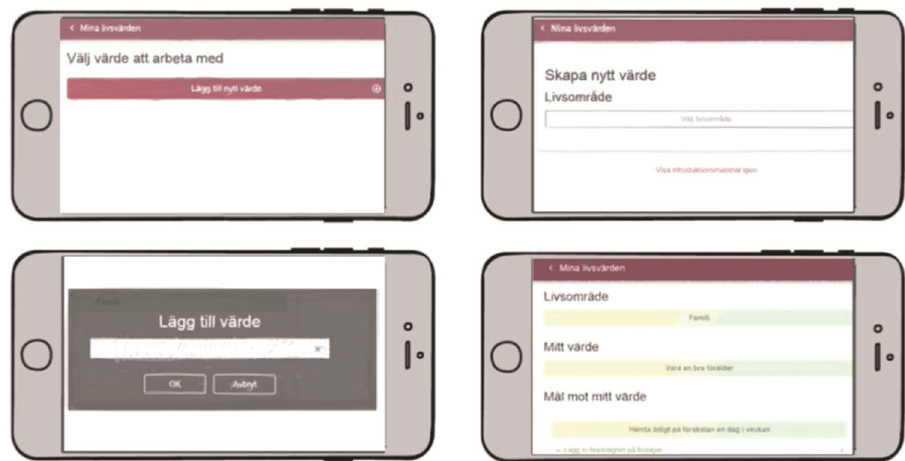
Fig. 4 Each step for formulation of values at end of alpha testing, approved by all alpha testers (the native